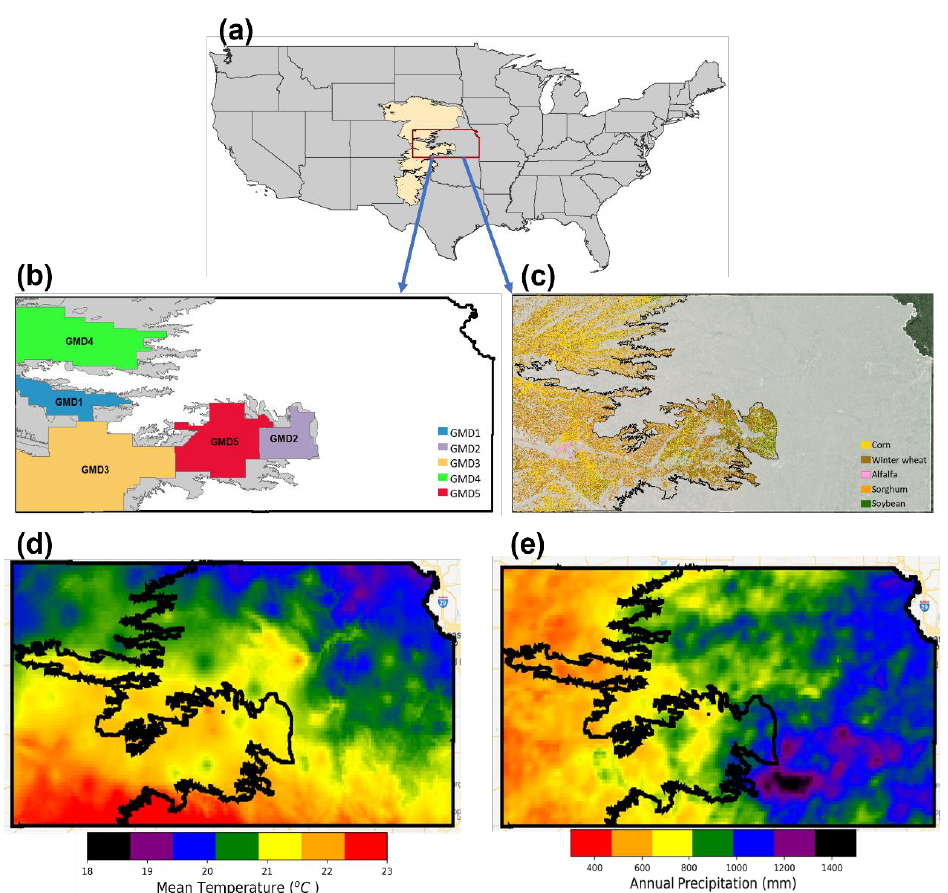
Figure 1. ( a ) Extent of the High Plains Aquifer (HPA), ( b ) Kansas portion of HPA and five ground- water management districts (GMDs), ( c ) distribution of major crop types, ( d ) mean annual temperature (°C) and ( e ) annual precipitation (mm) in 2016, a year with normal hydrometeorological con- ditions.